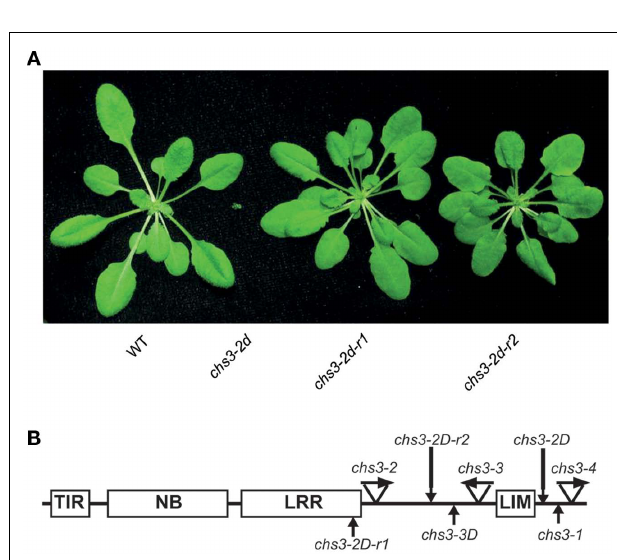
FIGURE 5 | Identification of chs3-2D revertants and location of a number of chs3 mutations. (A) Morphology ofWT, chs3-2D npr1-1 , chs3-2D-r1 , and chs3-2D-r2 soil-grown plants. Representative plants were photographed 4weeks after germination. (B) Predicted CHS3 protein structure and locations of chs3-1 (Yang et al., 2010), chs3-2D , chs3-3D , chs3-2D-r1 , and chs3-2D-r2 mutations.TIR,Toll/Interleukin-1-receptor-like; NB, nucleotide-binding site; LRR, leucine-rich repeat; LIM, Lin-11, Isl-1, and Mec-3 domain. Arrows indicate the locations of the point mutations corresponding to chs3